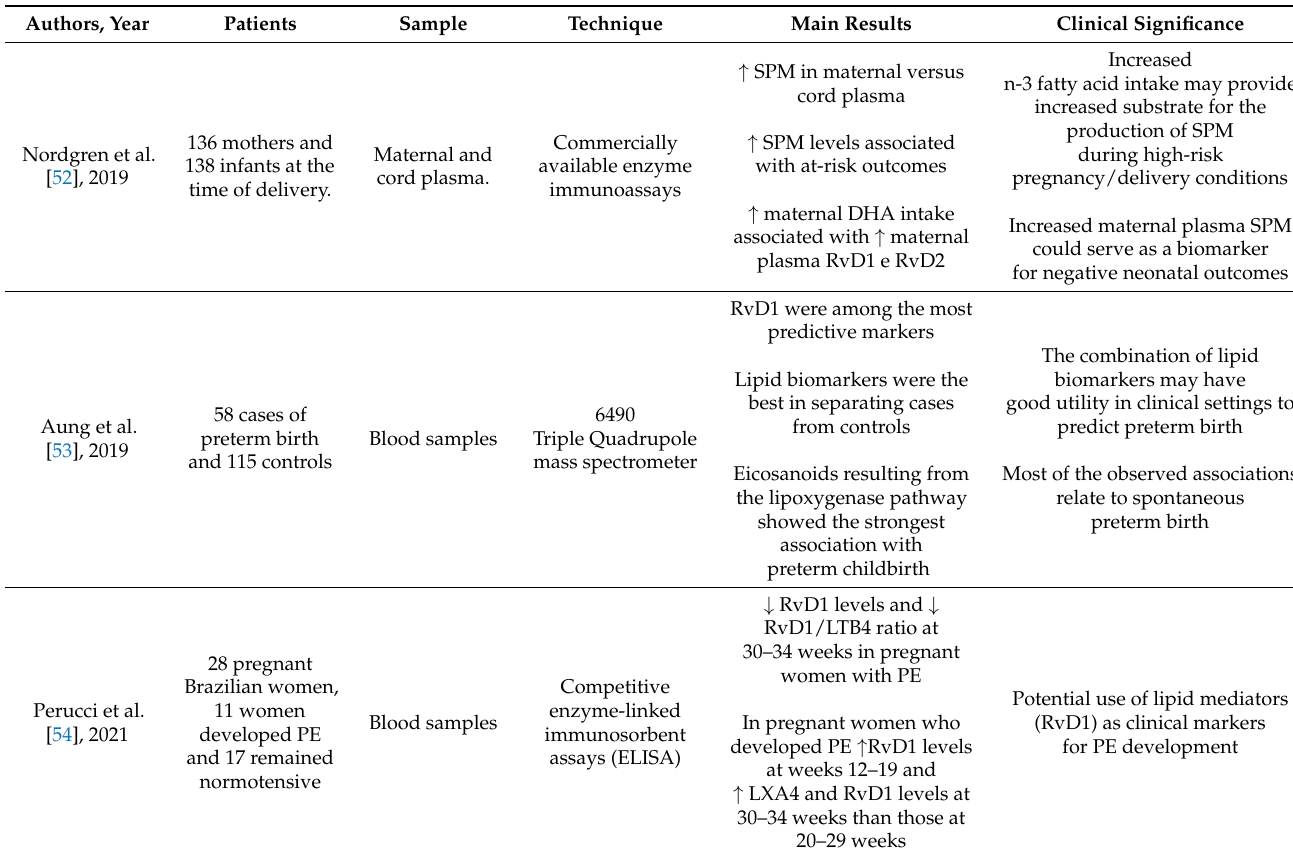
Table 1. Studies analyzing resolvins’ utility in clinical settings to predict pregnancy